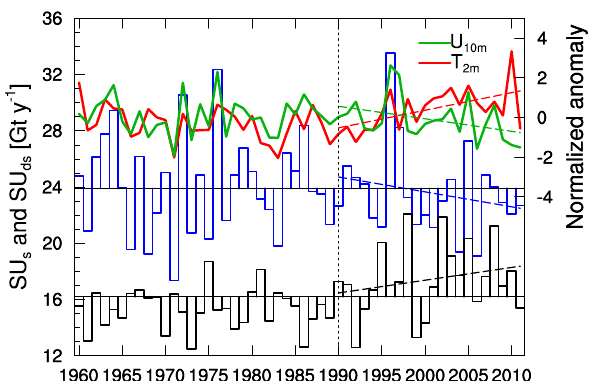
Fig. 10. Interannual variability (1960–2011) of GrIS integrated SU ds (blue bars) and SU s (black bars), combined with the normal- ized anomaly of GRis averaged 10m wind speed ( U 10 m, green) and 2m temperature ( T 2 m, red). The 1990–2011 linear trends are depicted by the dashed